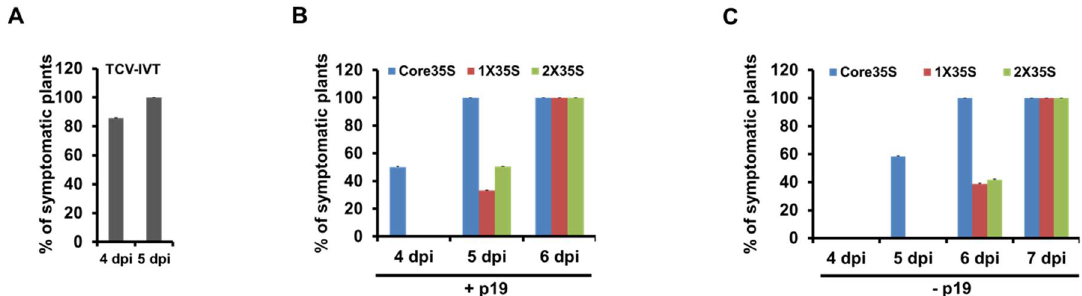
Figure 3. Symptom expression of the wildtype TCV on N. benthamiana . ( A ) Symptom expression (%) with rub inoculation method using in vitro transcript (IVT) of wtTCV. ( B ) Symptom expression (%) with agroinfiltrated delivery of three different promoter-based wt TCV constructs; Core35SwtTCV, 1X35SwtTCV, and 2X35SwtTCV, along with p19-expressing construct onto leaves of healthy N. benthamiana plants. ( C ) Symptom expression (%) with agroinfiltration method using three different promoter-based wt TCV constructs without p19.